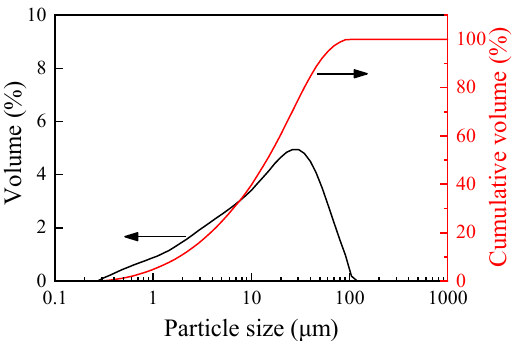
Figure 1. The particle size of calcium hydroxide powders.